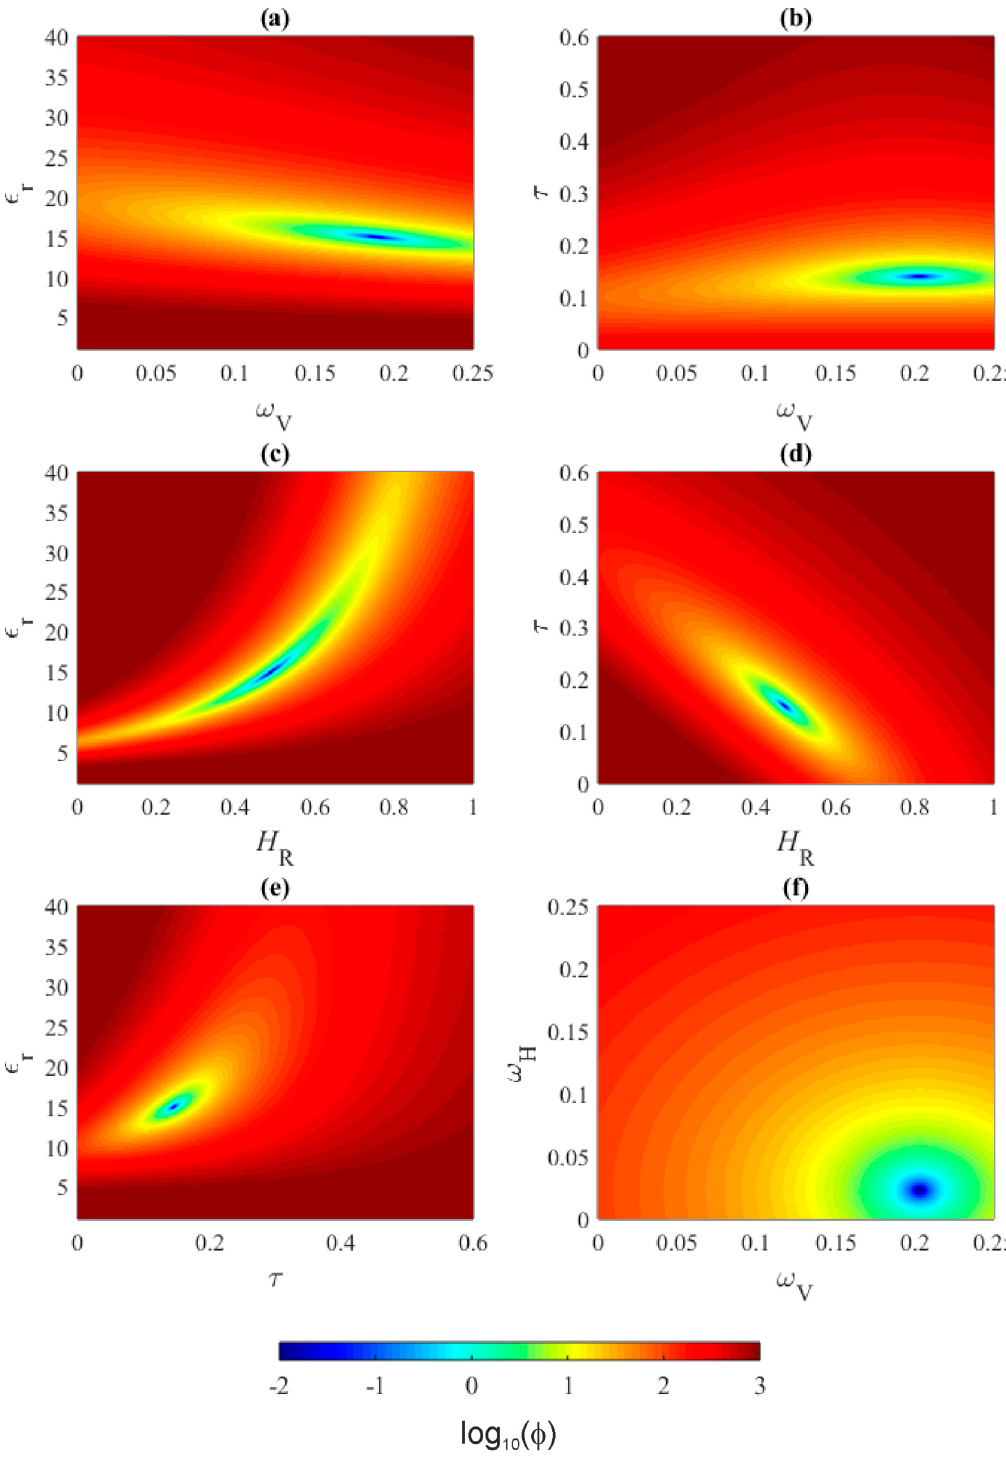
Figure 11. Response surfaces of the logarithm of the objective function (log 10 ( φ )) in the following parameter planes: ε r - ω V ( a ); τ - ω V ( b ); ε r - H R ( c ); τ - H R ( d ); ε r - τ ( e ); and ω H - ω V ( f ).